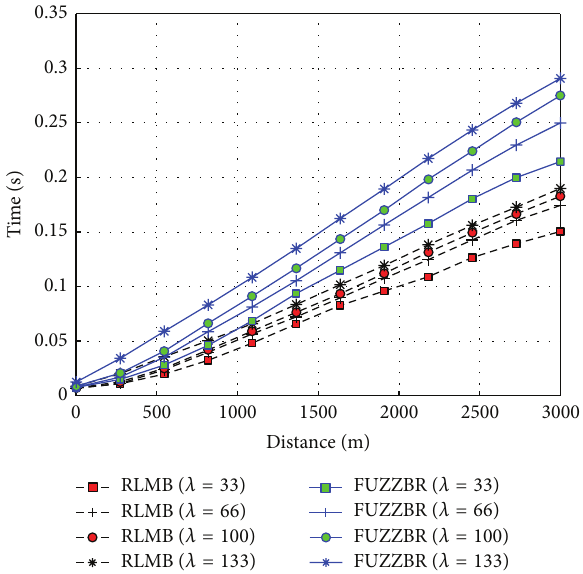
Figure11:EEDobtainedwithRLMB(0.25hps)andFUZZBR(1hps) when increasing the transmitter-receiver distance for different vehicles densities, 𝜆 .